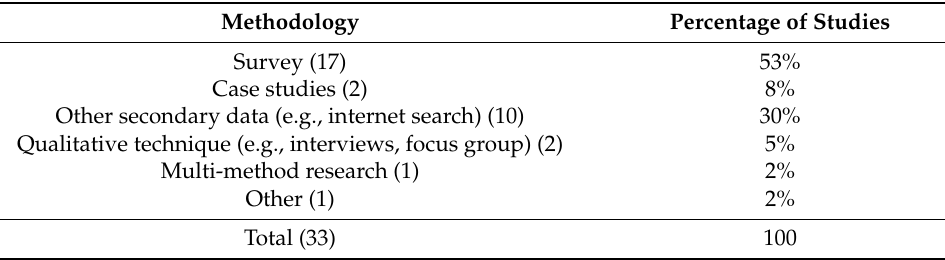
Table 2. Distribution of studies by